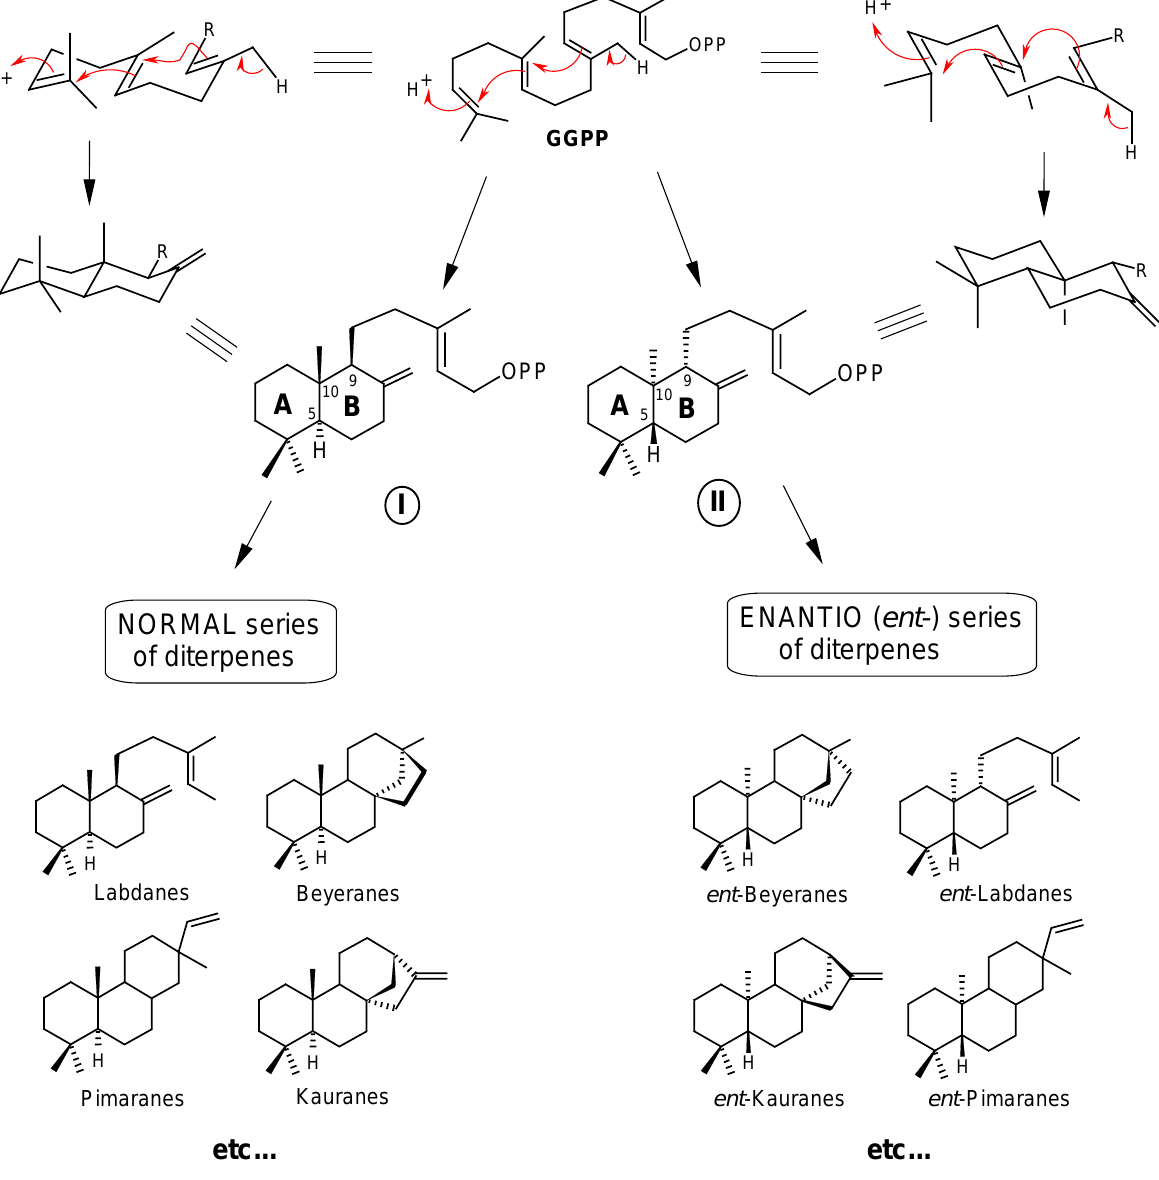
Figure 2. Cyclization of geranylgeranyl pyrophosphate (GGPP) under acid catalysis, leading to the diterpenes of the “NORMAL” and “ENANTIO” ( ent -)